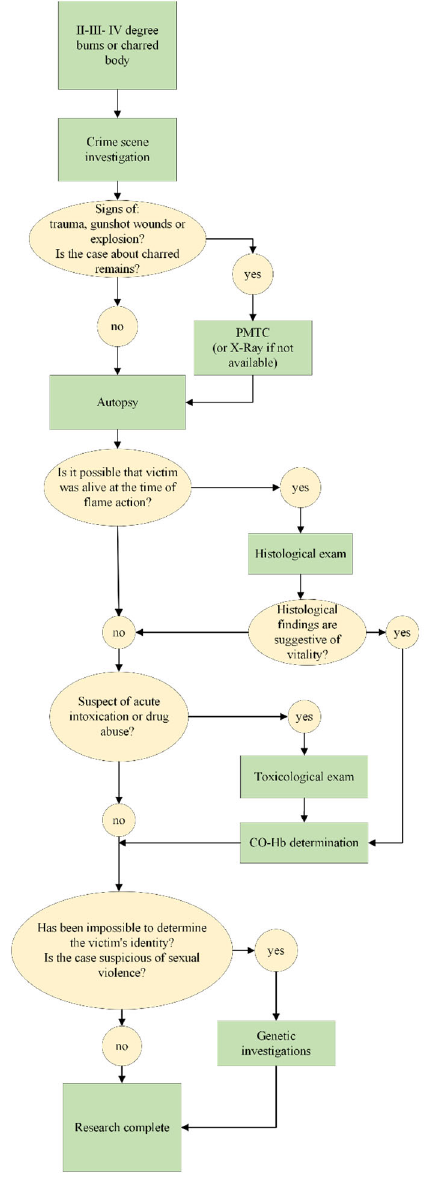
Figure 14. The representation of the proposed protocol to follow during the study of a charred body.